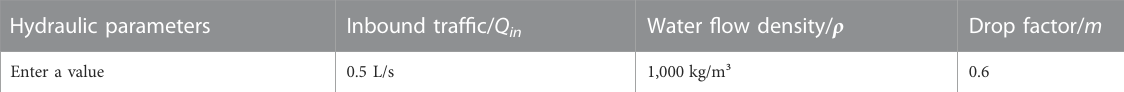
TABLE 2 Hydraulic parameter setting table.